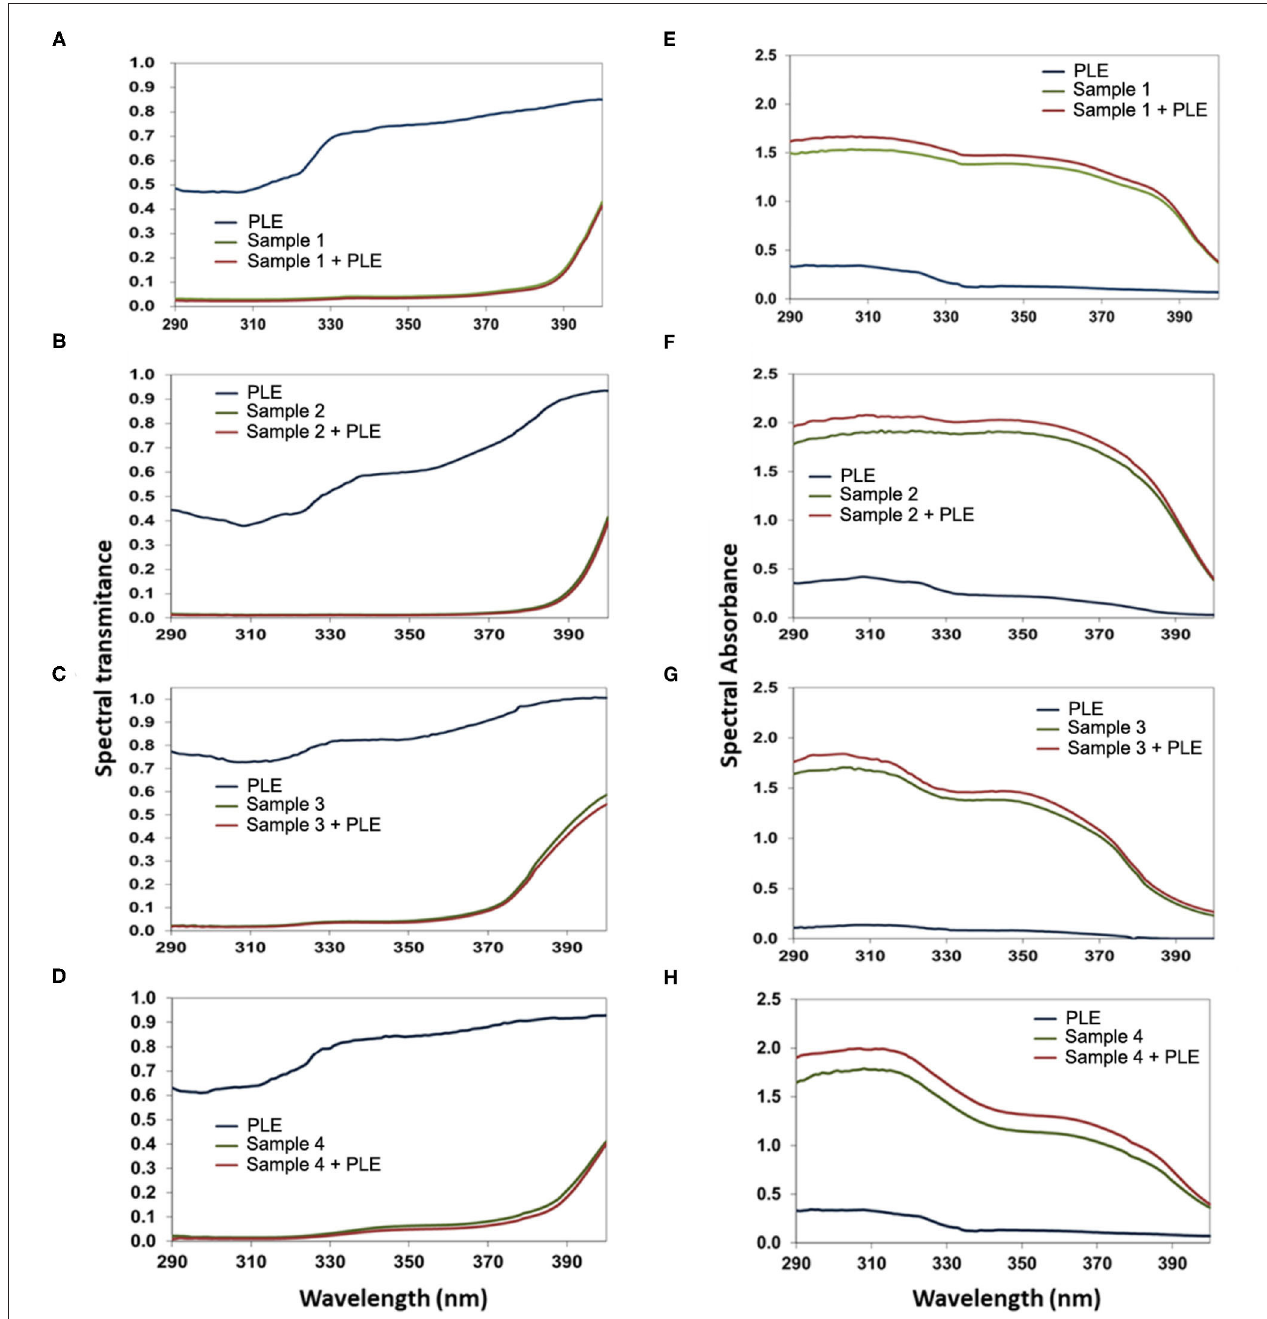
FIGURE 3 | Spectral transmittance (A–D) and absorbance (E–H) of PLE alone, sample 1 (A,E) , 2 (B,F) , 3 (C,G) , and 4 (D,H) without PLE, or a combination of both compared to the formula containing (Sample 1–4) only filters and the formula containing only PLE (Sample 1–4 + PLE). Please refer to the Materials and Methods section and Table 1 for details on the formulations used in each